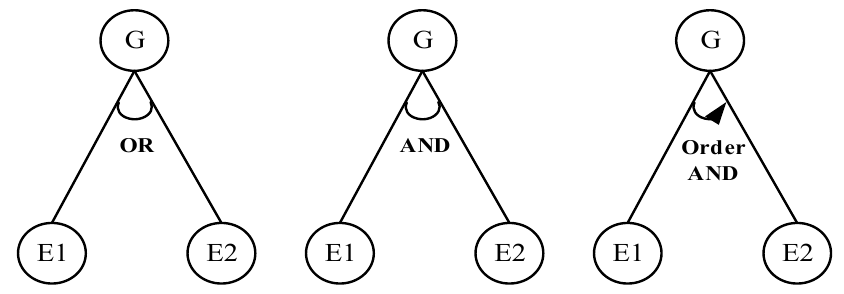
Figure 2. Node representations in the attack tree (AT).